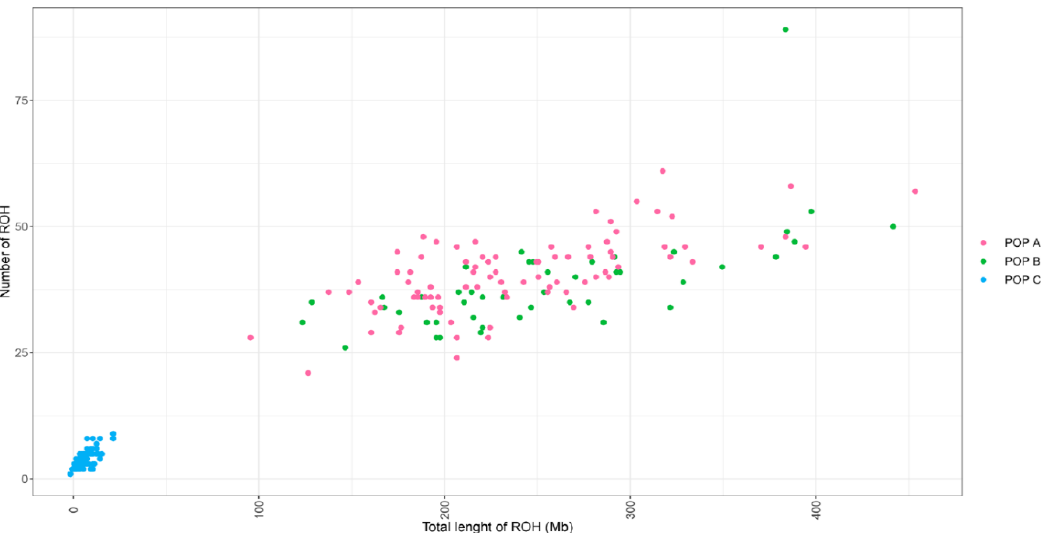
Figure 4. Relationship between the number of runs of homozygosity (ROH) and total length of ROH (Mb) per individual from each population.